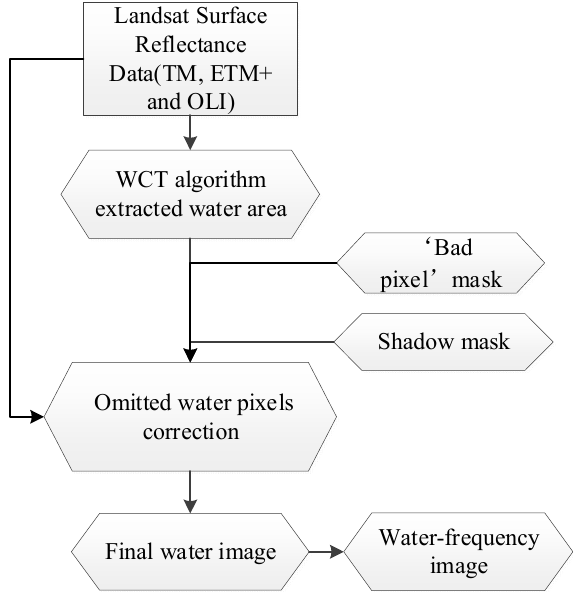
Figure 3. The flow chart of the Landsat-based water extraction method improved water change tracking (IWCT) algorithm developed in this study.